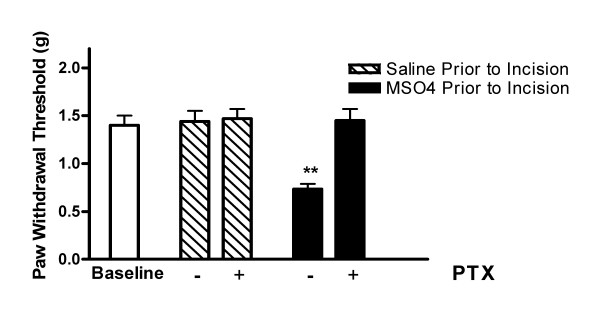
Mechanical allodynia after incision as affected by morphine and pentoxifylline. In these experiments mice were subjected to nociceptive testing of the hind paw to establish the baseline threshold. Mice were then pre-treated with either saline or morphine for 4 days prior to hind paw incisions being made. After incision, groups of mice were treated daily with daily intraperitoneal saline or pentoxifylline as described in Methods. Nociceptive testing 72 hours after hind paw incision (2 hours after the last dose of pentoxifylline). **p < 0.01, N = 8/group.